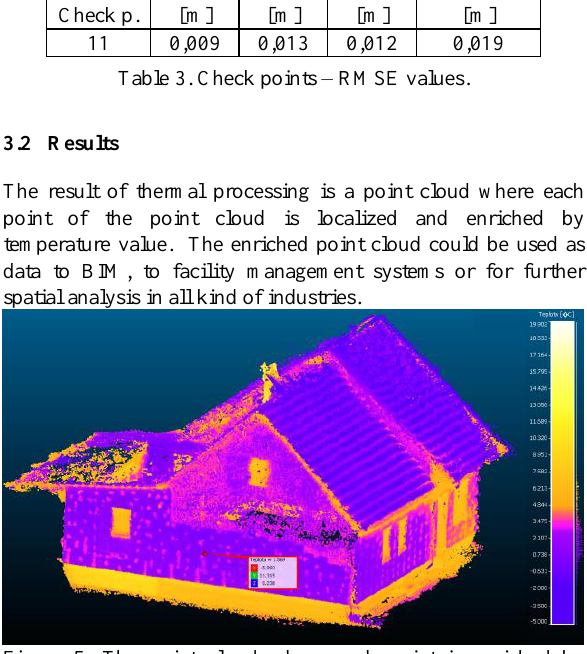
Table 2. Control points – RMSE values. Num. of